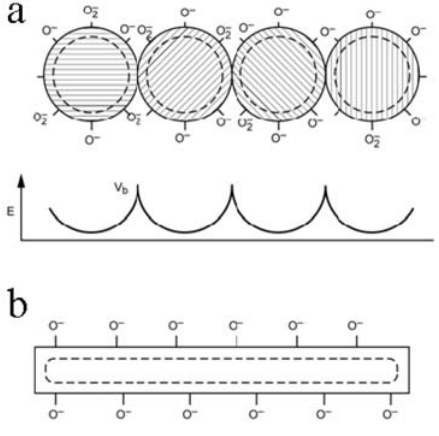
Figure 1. Schematic illustration of (a) potential barriers between nanoparticles formed by the juxtaposition of depletion layers within a polycrystalline nanofiber and (b) the continuous depletion layer surrounding the